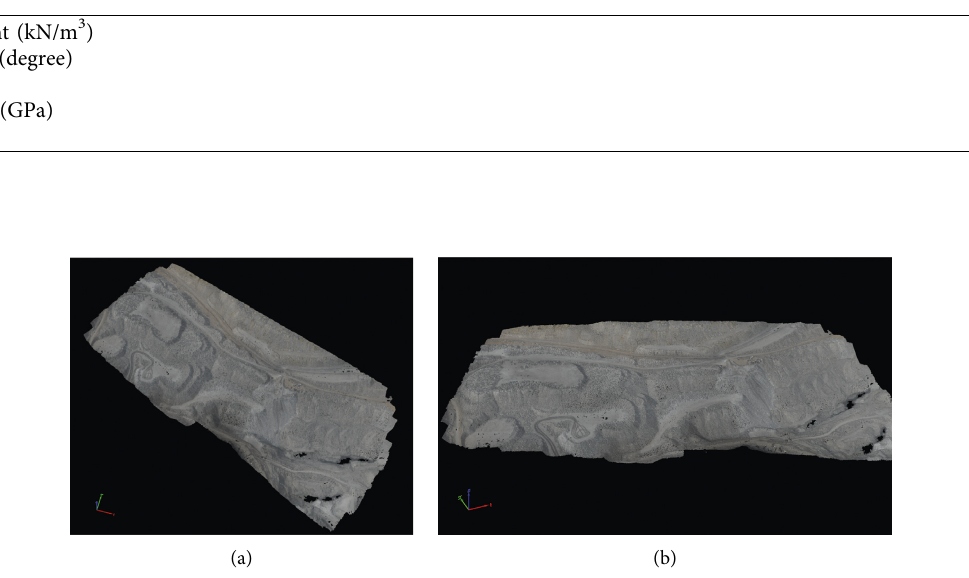
Figure 6: (a, b) 3D models of the study area created from UAV imagery from different